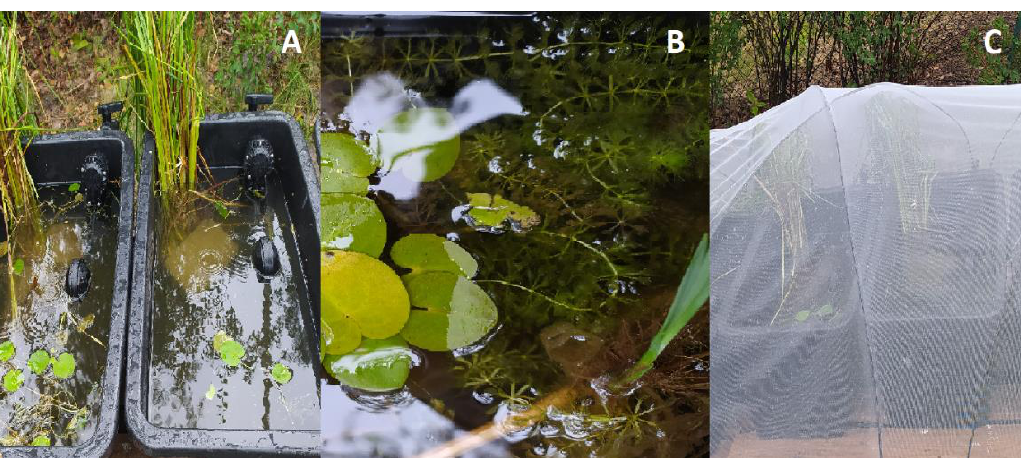
Figure 4. Aldrovanda vesiculosa plants in outdoor tanks; ( A ) tanks filled with lake water, visible clumps of grass and automatic water filling system; ( B ) floating aldrovanda shoots; ( C ) net covering tanks.